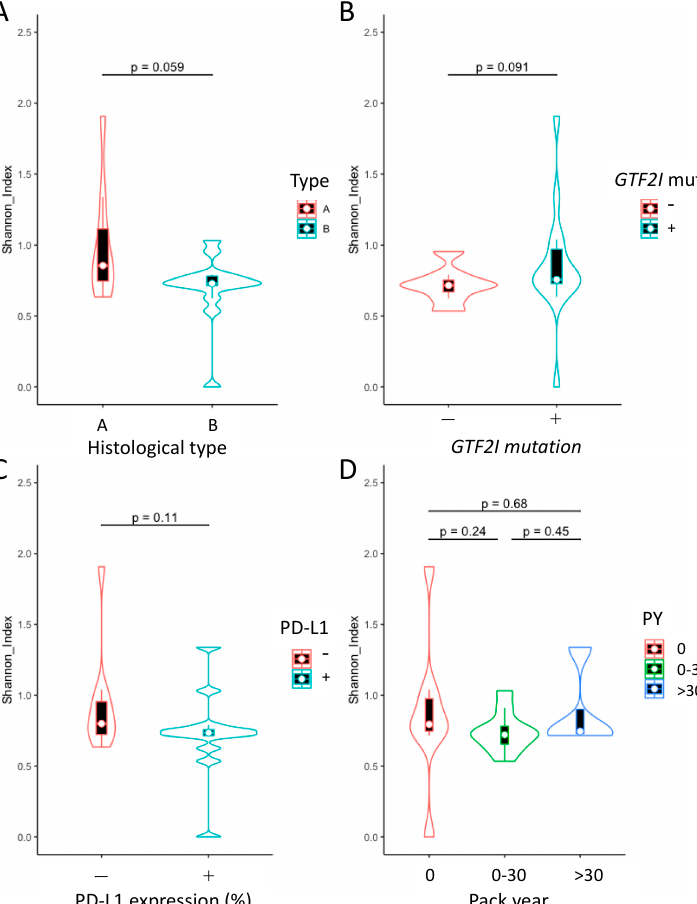
Figure 3. Taxonomic alpha diversity of thymoma microbiomes within samples in different groups. ( A ) Comparison of the Shannon Index between type A and B histology groups. ( B ) Comparison of the Shannon Index between tumors exhibiting the presence and those exhibiting an absence of the GTF2I driver mutation. ( C ) Comparison of the Shannon Index between tumors exhibiting the presence and those exhibiting an absence of PD-L1 expression on tumor cells. ( D ) Comparison of the Shannon Index among nonsmokers, light smokers, and heavy smokers. No significant difference was found among these groups.